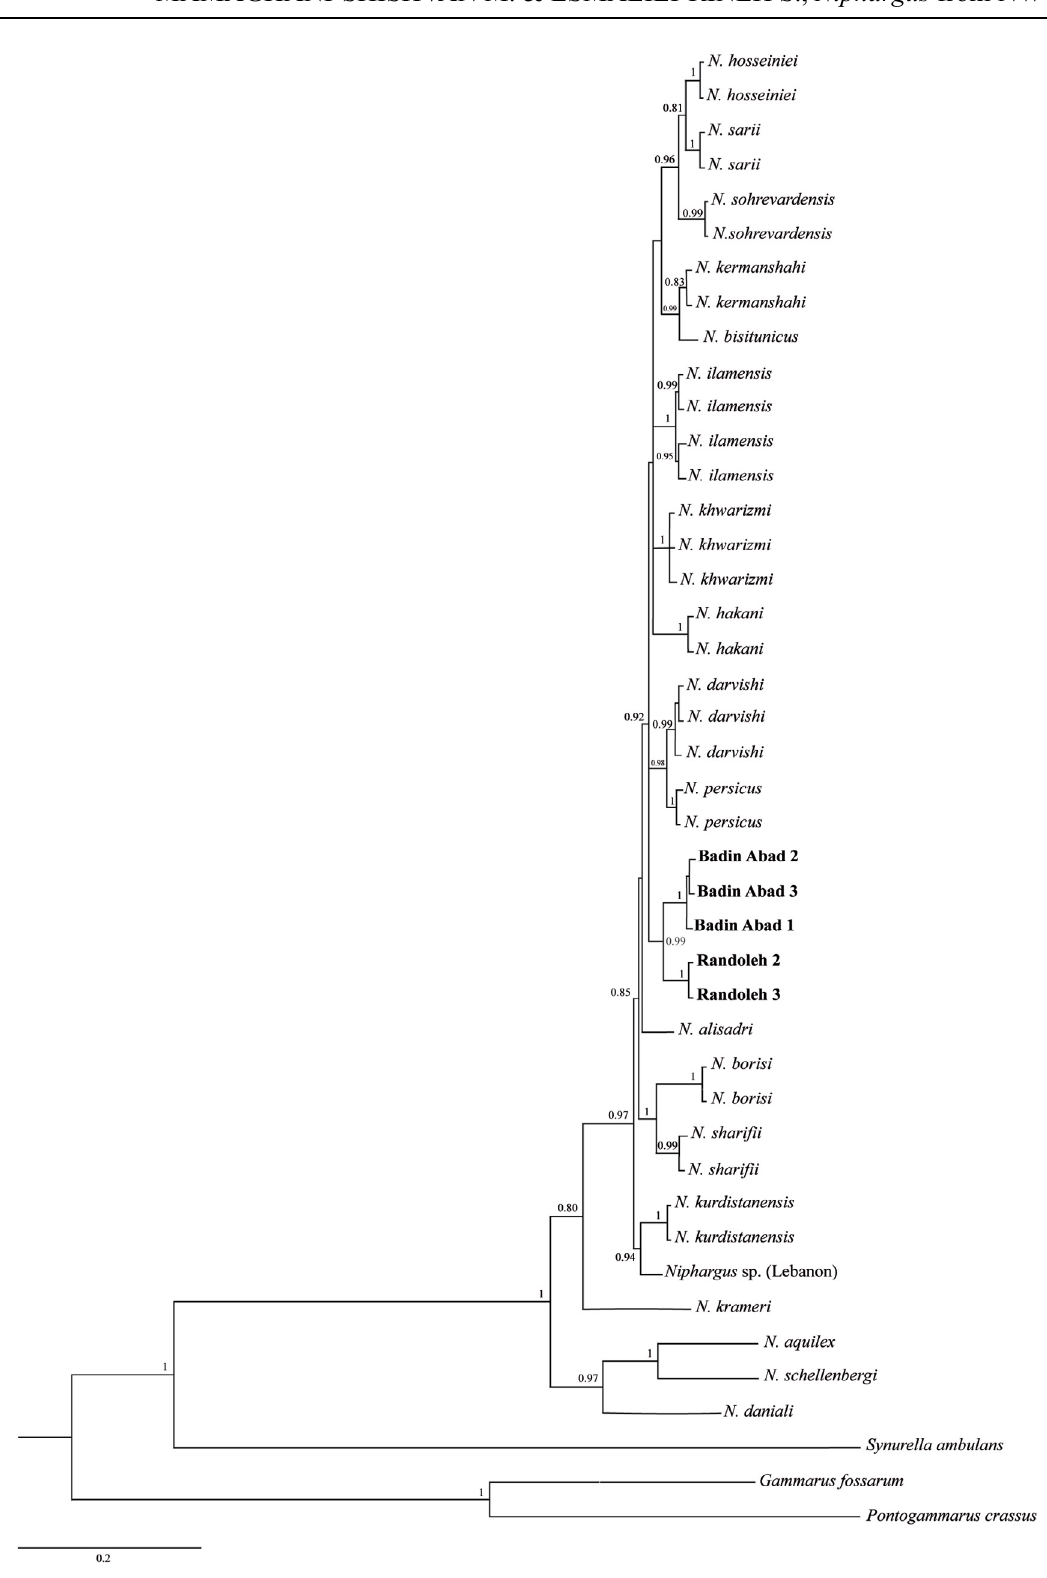
Fig. 2. Bayesian tree of 43 specimens as inferred from the 28S and COI gene sequences. Species are identified and named according to available taxonomic descriptions. Bayesian posterior probabilities more than 0.8 are indicated above